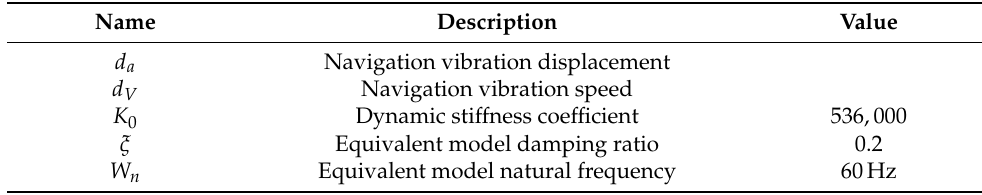
Table 3. Parameters of the landing gear lateral stiffness